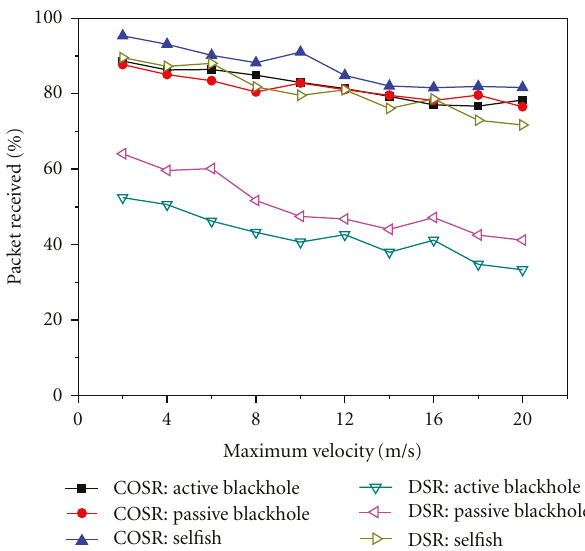
Figure 11: APL of COSR and DSR with various maximum